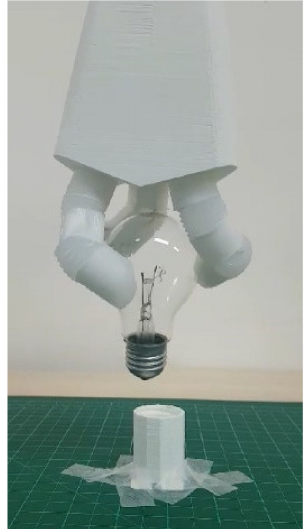
Figure 6. Image of a soft gripper performing a rotation